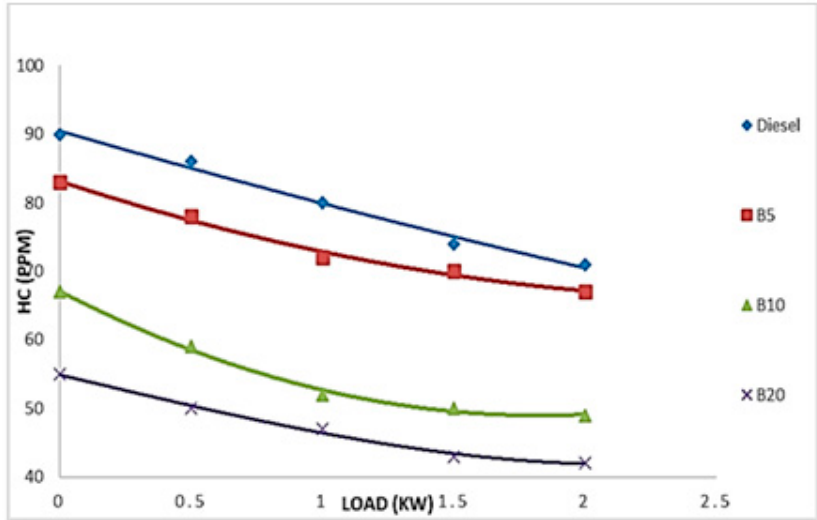
Figure 10. Variation in HC with respect to load.